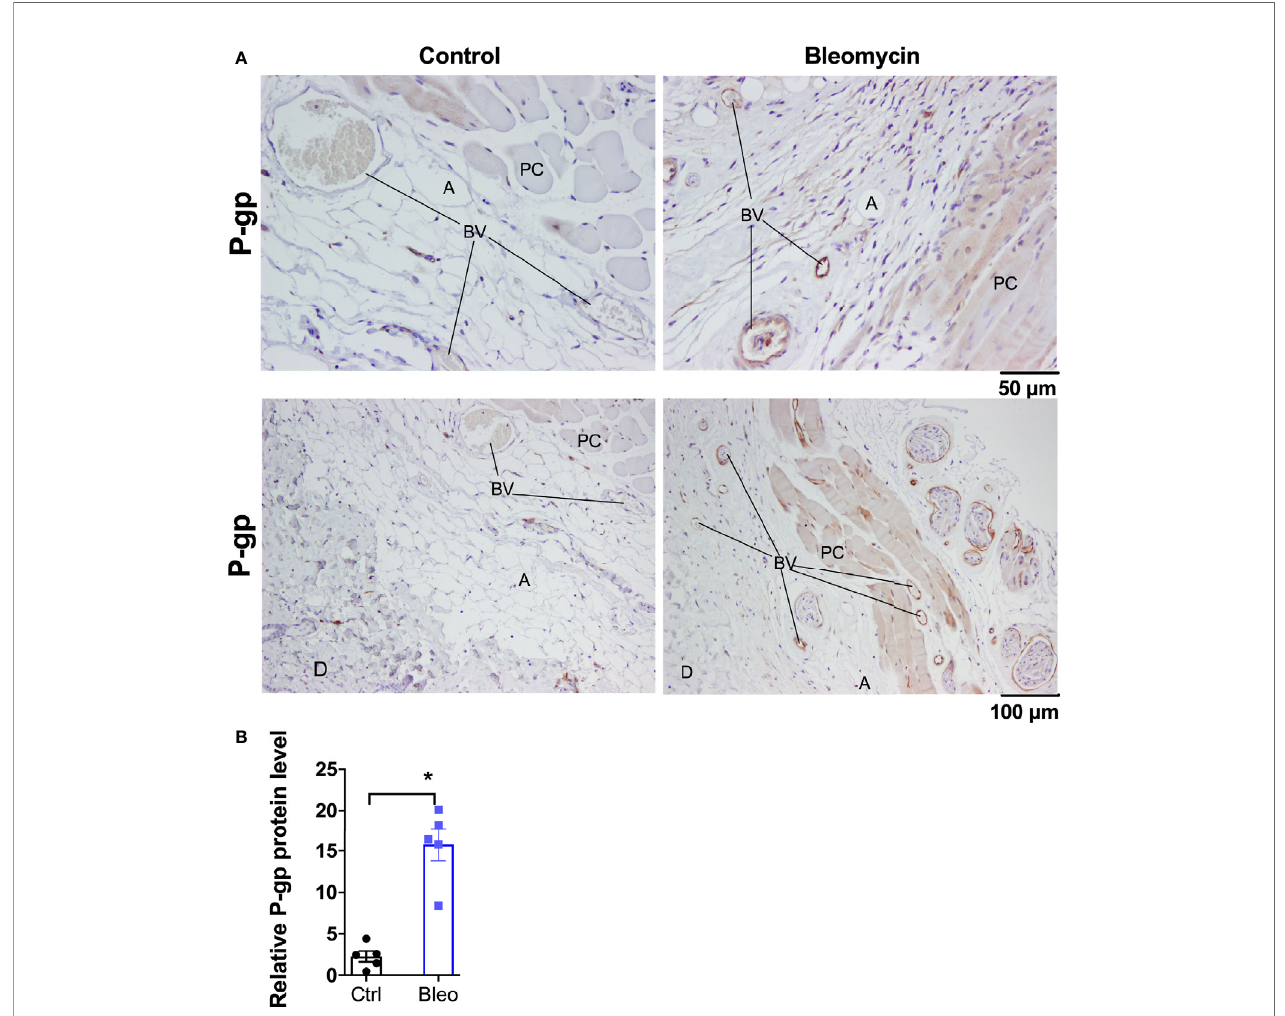
FIGURE 2 | Bleomycin induces drug ef fl ux transporter P-gp in skin of C57BL6/J mice. (A) Representative histological images for P-gp immunohistochemistry staining in skin biopsies of control and bleomycin-induced fi brotic skin. A, adipocytes; BV, blood vessels; D, Dermis; PC, Panninculus carnosus. (B) Quanti fi cation of P-gp protein expression in skin biopsies. Data represent mean ± SEM from fi ve subjects in each group. Data were analyzed by t-test for comparison of histological scoring. * (p <0.05) indicates signi fi cant difference from the control